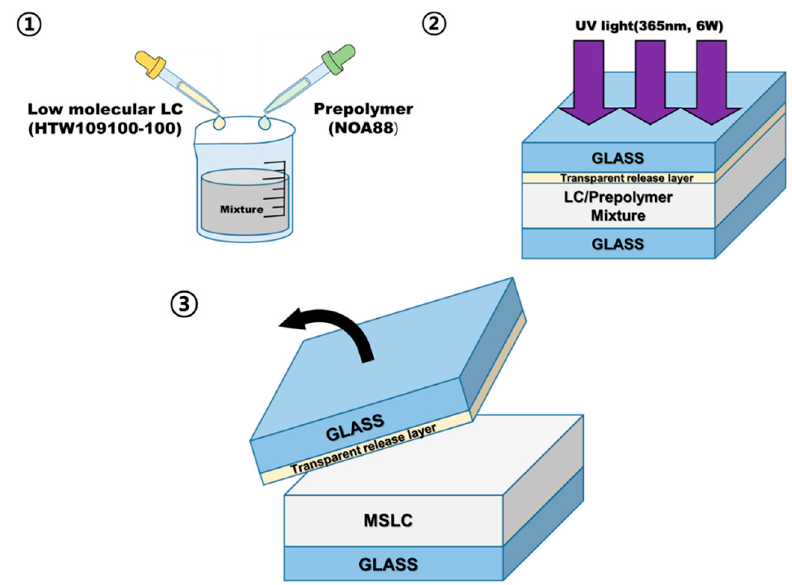
Figure 1. Schematic illustration of the fabrication procedure for our micro-segregated liquid crystal (MSLC) film.